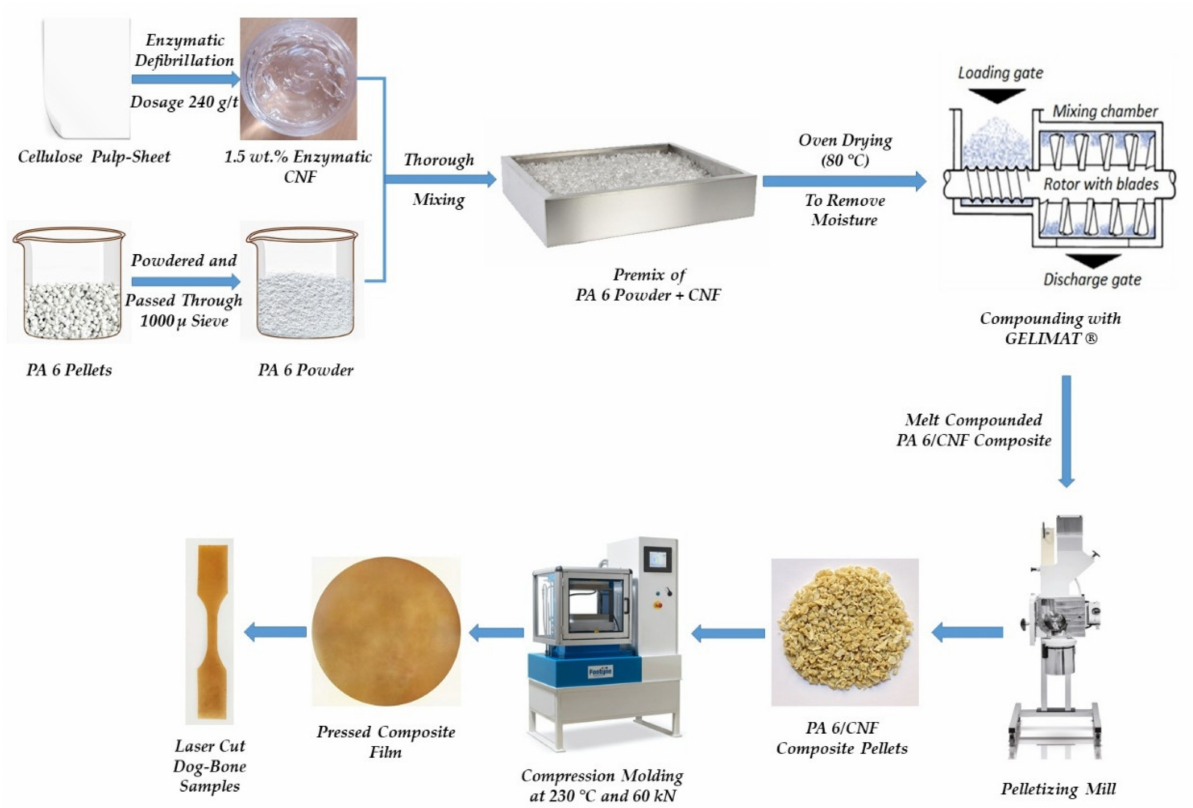
Figure 2. Schematic representaion of the manufacture process for PA 6/CNF nanocomposites